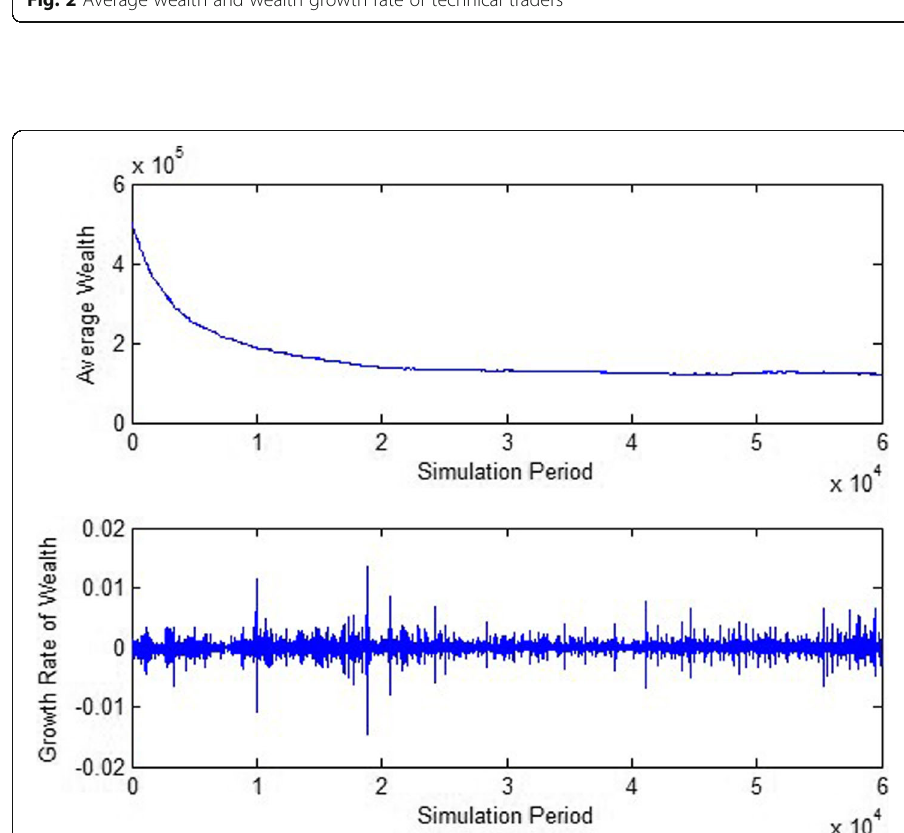
Fig. 3 Average wealth and wealth growth rate of noise